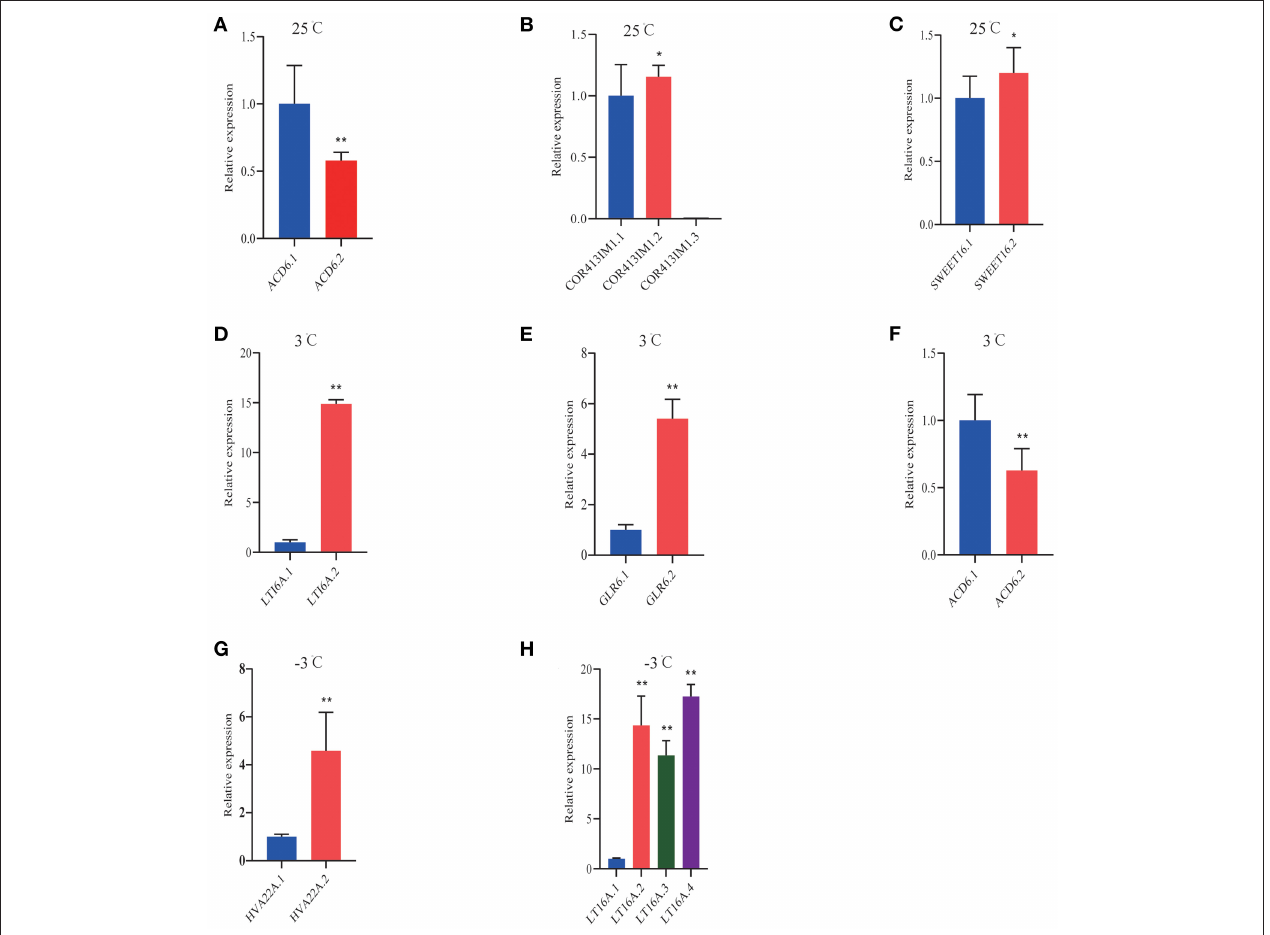
FIGURE 10 | QRT-PCR analysis of DAS isoforms response to cold stress in P. ussuriensis compared with P. trichocarpa . (A–C) DAS genes at 25 ◦ C. (D–F) DAS genes at 3 ◦ C. (G,H) DAS genes at − 3 ◦ C.